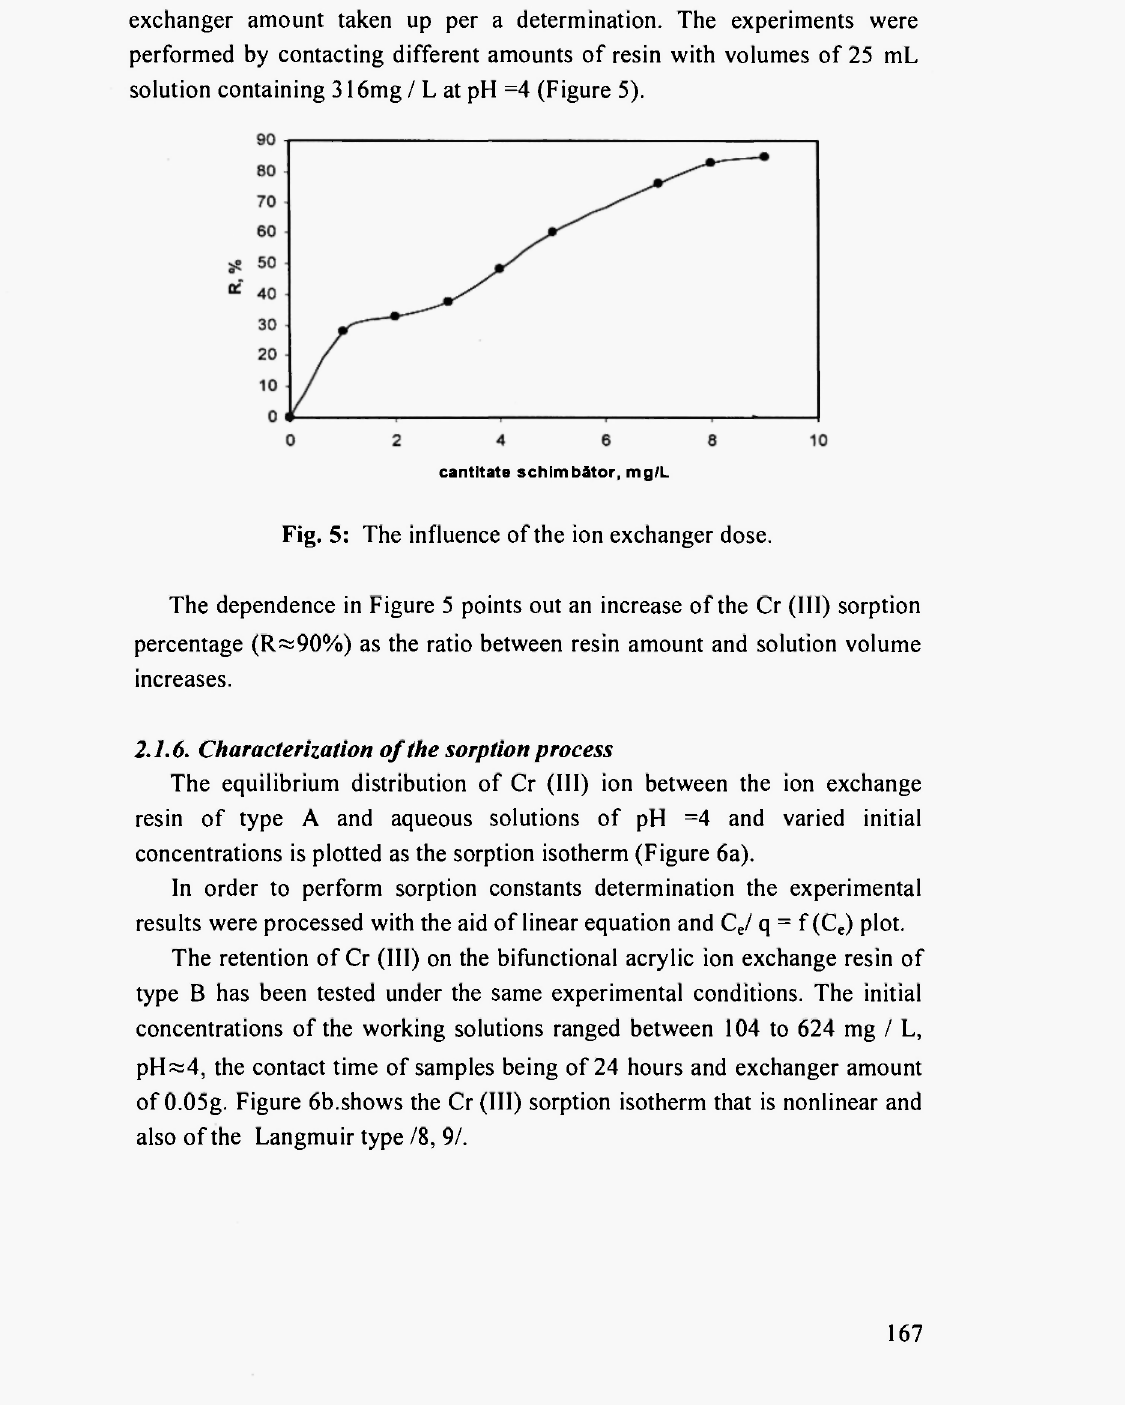
Fig. 5: The influence of the ion exchanger